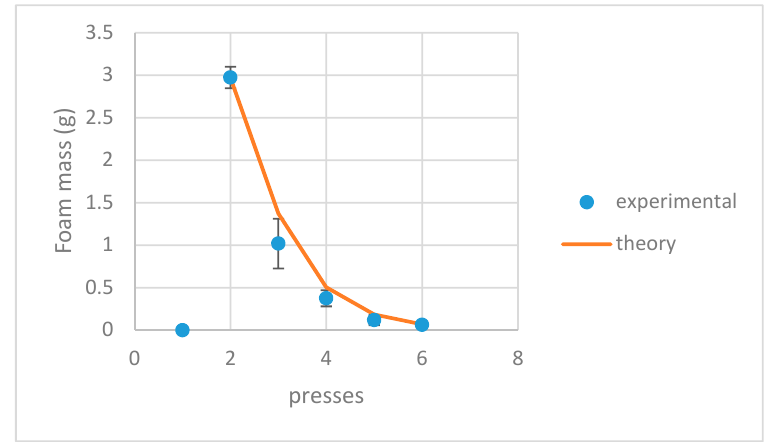
Figure 6. Foam mass for each compression of a dishwasher sponge saturated with 10 cmc SDS solution along with the theoretically predicted values using Equation (20). The pressure applied 2.5 bar = 5202 N.